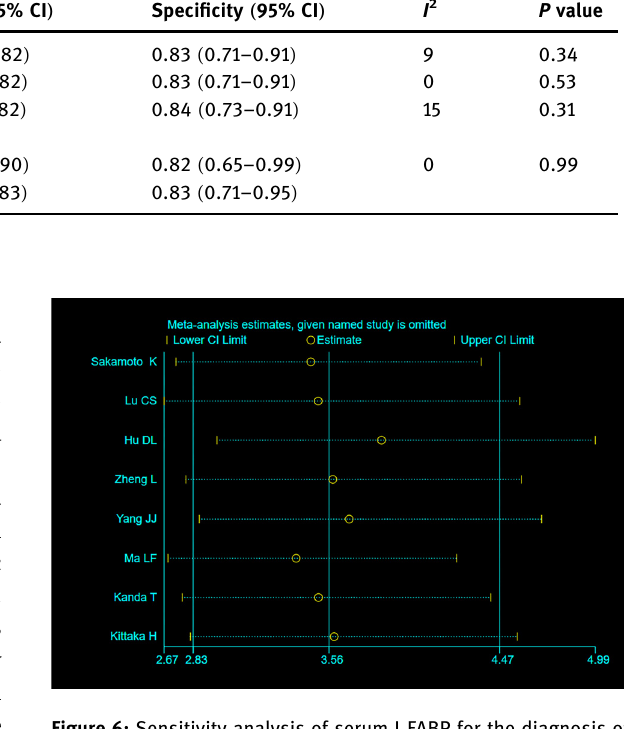
Figure 6: Sensitivity analysis of serum I - FABP for the diagnosis of strangulated intestinal obstruction.